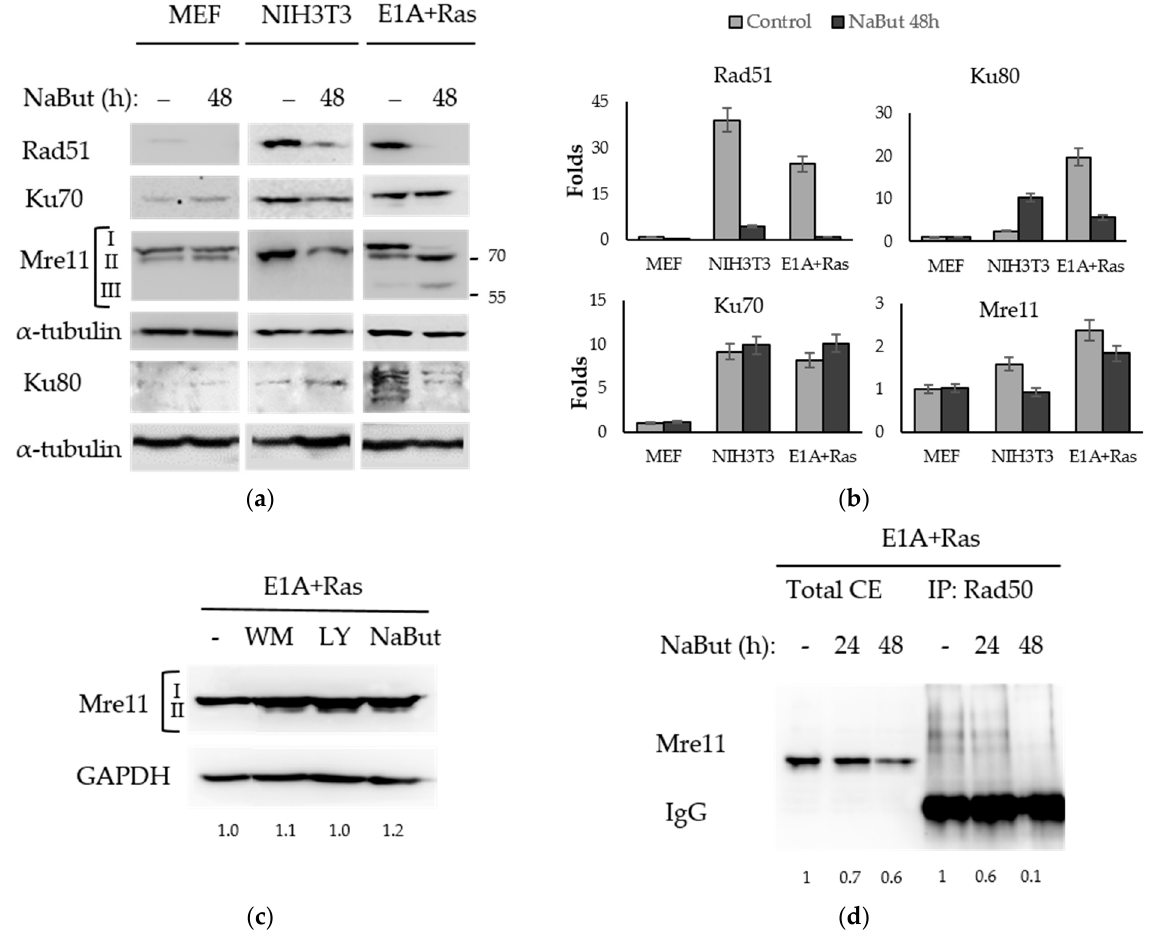
Figure 4. NaBut modulates the repair proteins in transformed cells. ( a ) Immunoblotting with antibodies to repair proteins using normal (MEF, NIH3T3) and transformed (E1A+Ras) cells untreated ( − ) or treated with 4 mM NaBut for 48 h. Immunoblotting with α -tubulin antibodies were used as a loading control. I—hyperphosphorylated Mre11, II—hypophosphorylated Mre11, III—truncated Mre11. ( b ) The bar plots represent band densities, evaluated using Image J © soft, scaled to the loading control, and normalized to the band density in untreated MEF cells (folds). For Ku80 and Mre11 proteins, the relevant plots display the aggregated intensity of all detected bands at each specific point, both for untreated and NaBut-treated cells. ( c ) Immunoblotting with antibodies to Mre11 using E1A+Ras cells untreated ( − ) or treated with 2.5 µM wortmannin (WM), 20 µM LY294002 (LY), or 10 mM NaBut for 8 h. GAPDH expression was used as a loading control. ( d ) Immunoblotting with antibodies to Mre11 using E1A+Ras cells untreated ( − ) or treated with NaBut for 24–48 h. Lanes 1–3 represent total cell extracts (total CE), and lanes 4–6 represent extracts co-precipitated with Rad50 antibodies.